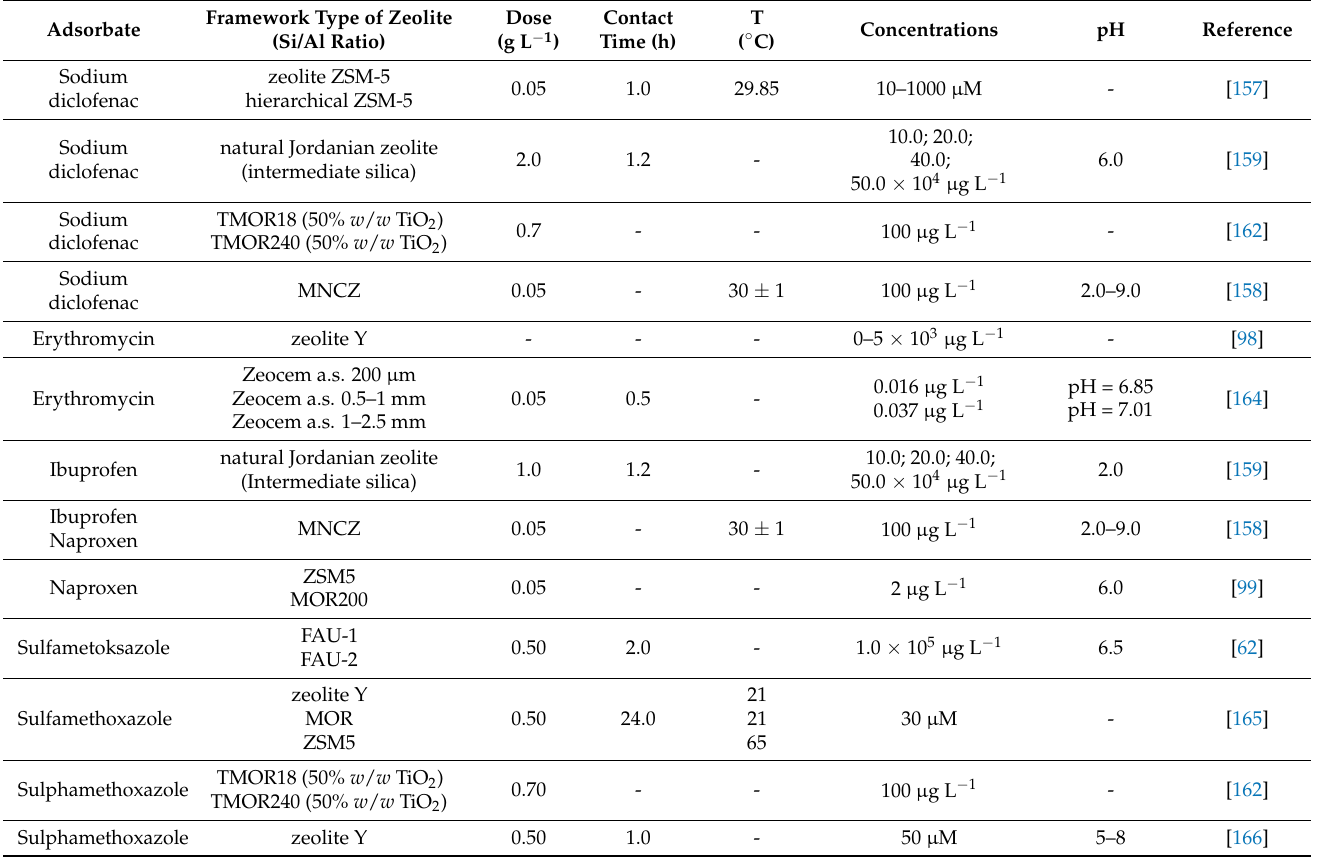
Sodium diclofenac